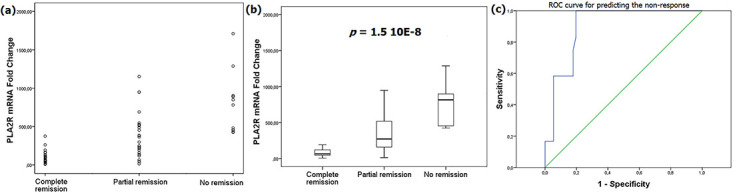
PLA2R mRNA relative expression and PMN outcome.(a) Dot plot showing the renal PLA2R expression in terms of PMN outcome. (b) Box plot highlighting significant higher PLA2R mRNA levels in non-remission patients. (c) ROC curve for PLA2R mRNA levels in predicting non-remission: AUC = 90% [0.826–0.973], p<0.0001; cut-off = 535.67, Sensitivity = 58.3%, specificity = 91.1%.